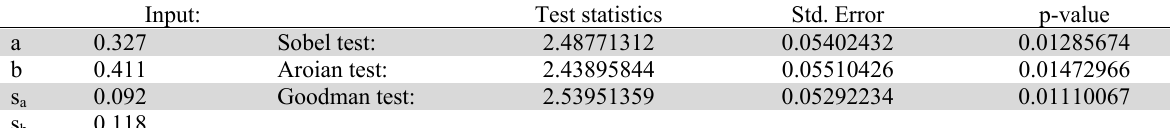
Result of mediating role of CRM in relationship between digital marketing and online purchase intention using Sobel Test